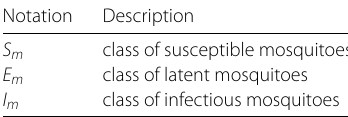
Table 2 Parameters for vectors